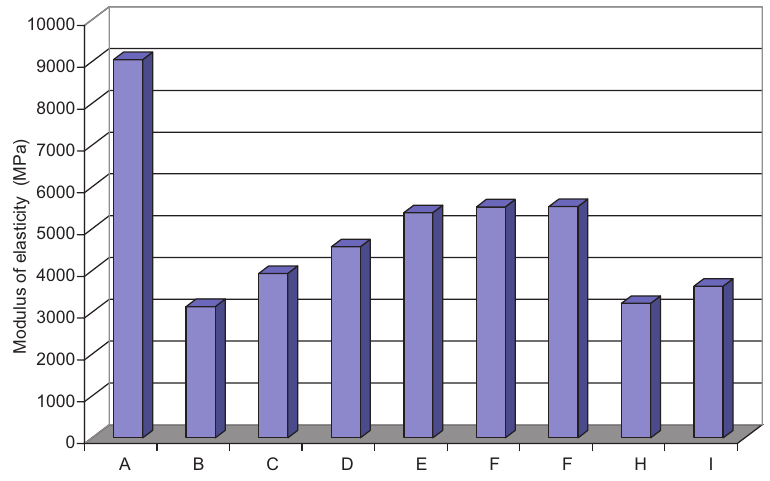
Figure 2 Modulus of elasticity of boards.